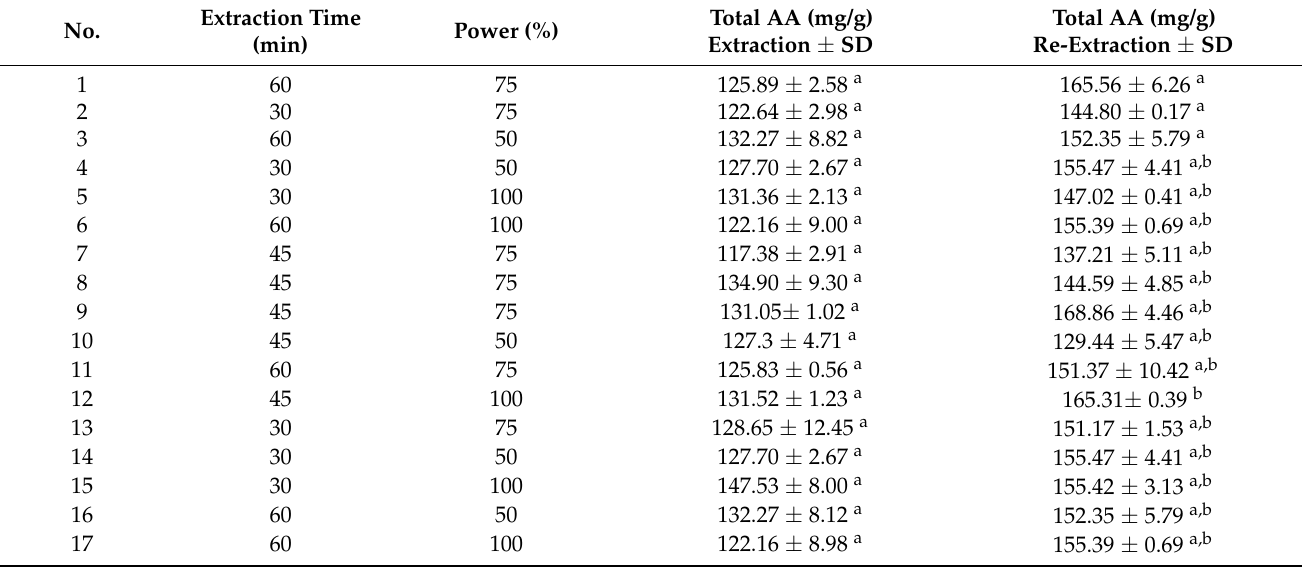
Table 9. Total essential amino acid profile for the Ultrasound-Assisted Extraction and